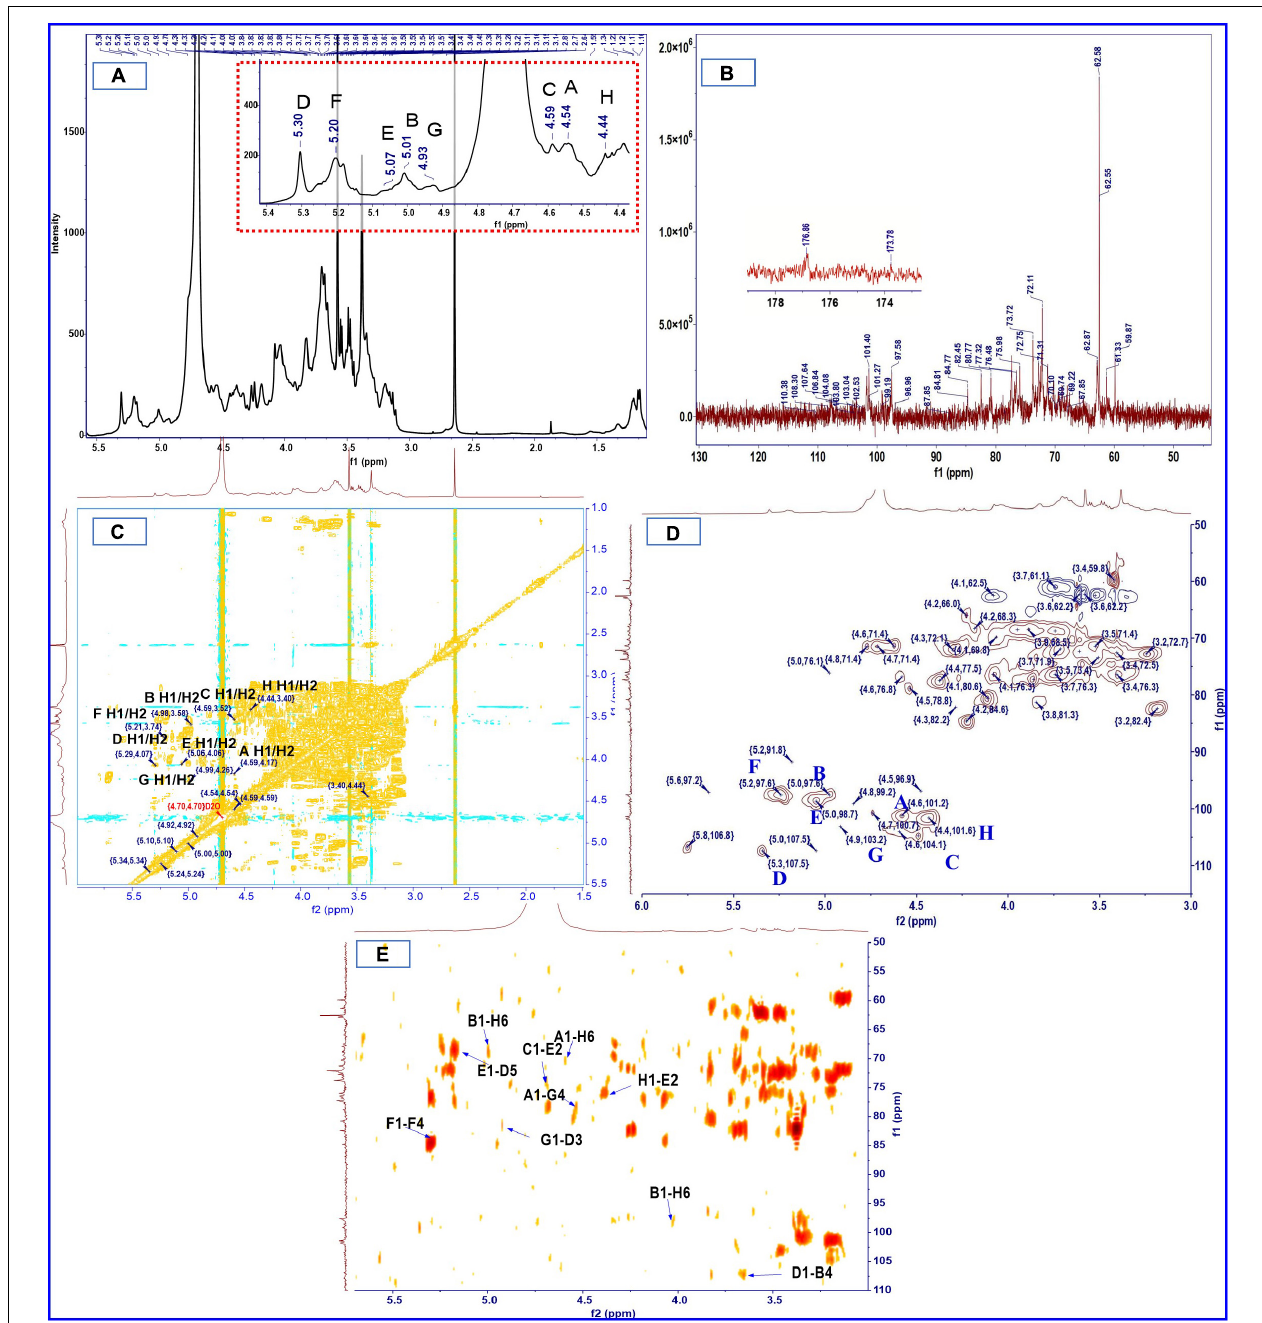
( Figure 2E ). For instance, the correlation can be found between C-2/C-3 and H-1 in one monosaccharide sugar unit or polymers. Therefore, combining the above analysis and reference (55), these chemical shifts were attributed to the T- β - L -Rha p (A). In the same way, through the analysis of data and references (56–63), every residue (A-H) was identified, and the chemical shifts are list in Table 3 .